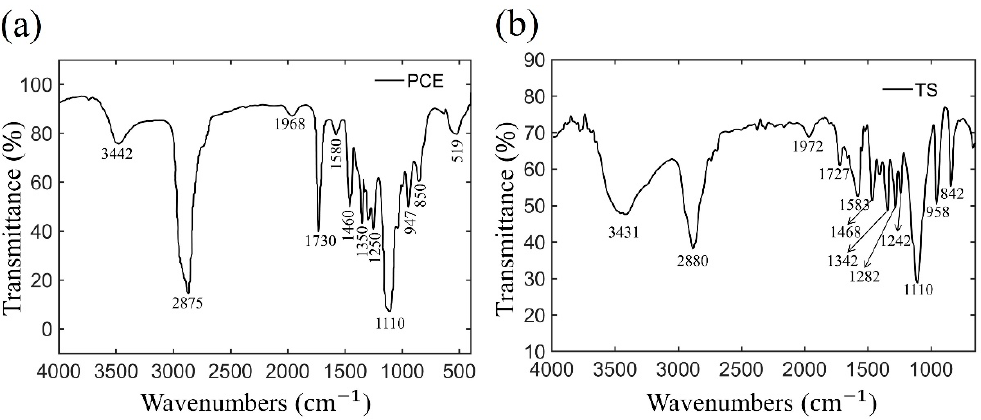
Figure 1. IR spectra for ( a ) polycarboxylate superplasticizers and ( b ) slump-retaining polycarboxylate superplasticizer.